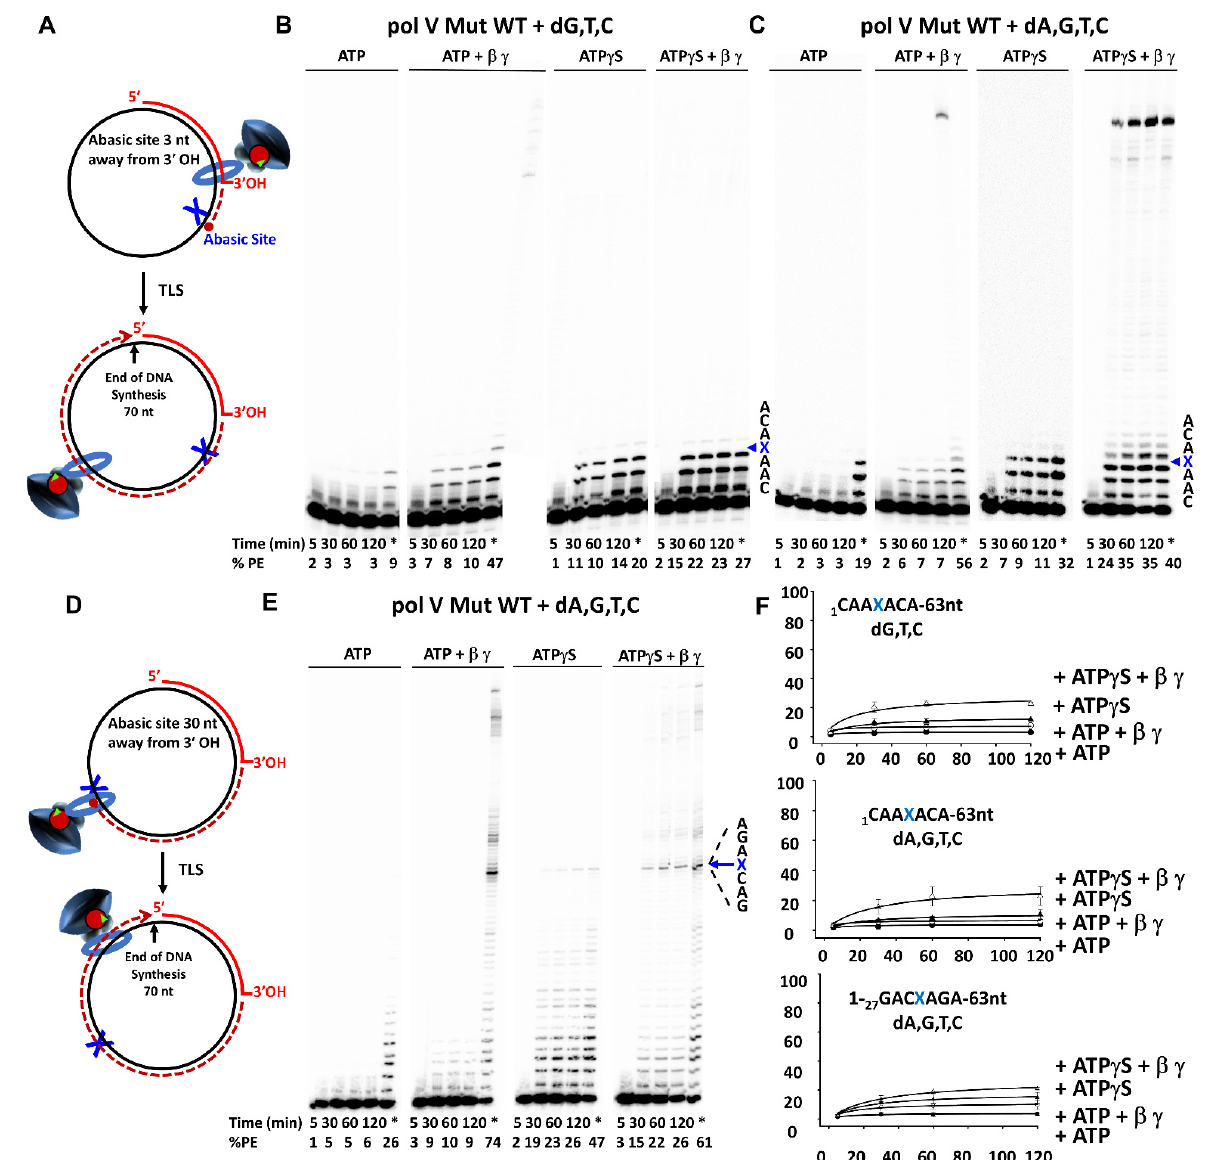
Figure 4. Translesion synthesis (TLS) by Pol V Mut Wild-Type (WT) on p/t DNA containing abasic site. ( A , D ) Sketch showing TLS by pol V Mut wt in presence of β -clamp on p/t DNA containing abasic site located 3 nt ( A ) and 30 nt ( D ) from 3’-OH junction. ( B , C , E ) TLS of pol V Mut WT (400 nM) was measured on circular p/t DNA (20 nt primer/ 90 nt circle; 25 nM) in the presence and absence of β -clamp and γ -complex with saturating concentration of ATP/ATP γ S (500 µM) and with two sets of dNTPs: (B) dGTP, dTTP, dCTP and ( C , E ) dATP dTTP, dCTP, dGTP (500 µM each). ( B ,C ) activity of pol V Mut WT on p/t containing an abasic site 3 nucleotides away from 3’-OH of primer. ( E ) activity of pol V Mut WT on p/t containing abasic site 30 nucleotides away from 3’OH of primer. The abasic site is marked by X and nucleotides surrounding the abasic site highlighted in the figure. At 120 min, 400 nM of RecA * was added to the reaction to trans-activate the mutasome which is represented by *. The experiments were repeated 3 times and the average % PE (percent p/t DNA extended) with the SD (standard deviation) for each reaction time point is graphed in panel ( F ). With X located 3 nt from the primer-3’-end (Figure 4A–C), in the absence of dATP, pol V Mut WT was unable to perform TLS, nor could it incorporate directly opposite X with either ATP (pol V Mut WT-ATP) or ATP γ S (pol V Mut WT-ATP γ S), even with β / γ